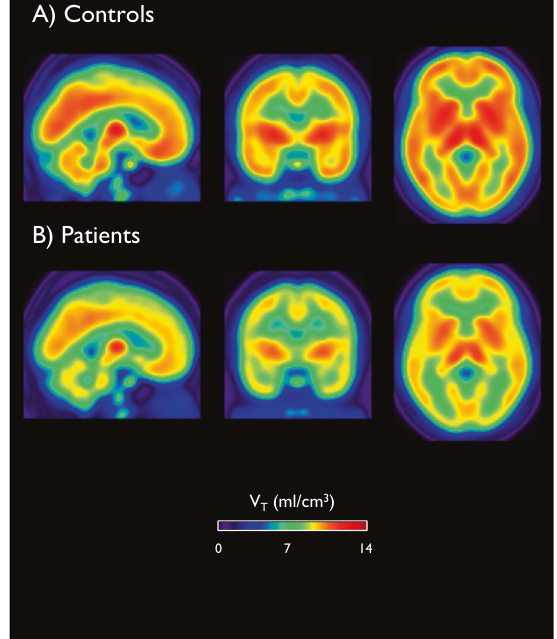
Fig. 2 [ 18 F]GE-179 V T . There was no signi fi cant difference in NMDAR availability in the hippocampus between patients and controls t 35 = 1.49, p = 0.15 as determined by the distribution volume ( V T ; measured in millilitres per cubic centimetre). Images are mean parametric maps for controls ( A ), sample ( B ). PANSS ( r = − 0.30, p = 0.21), and negative PANSS ( r = 0.08, p = 0.76). However, there was a signi fi cant negative correlation between hippocampal V T and general PANSS ( r = − 0.53, p = 0.02, eFigure 4 in Supplementary Material), and the depression item of the PANSS ( r = − 0.56, p = 0.01, eFigure5 in Supplementary Material).